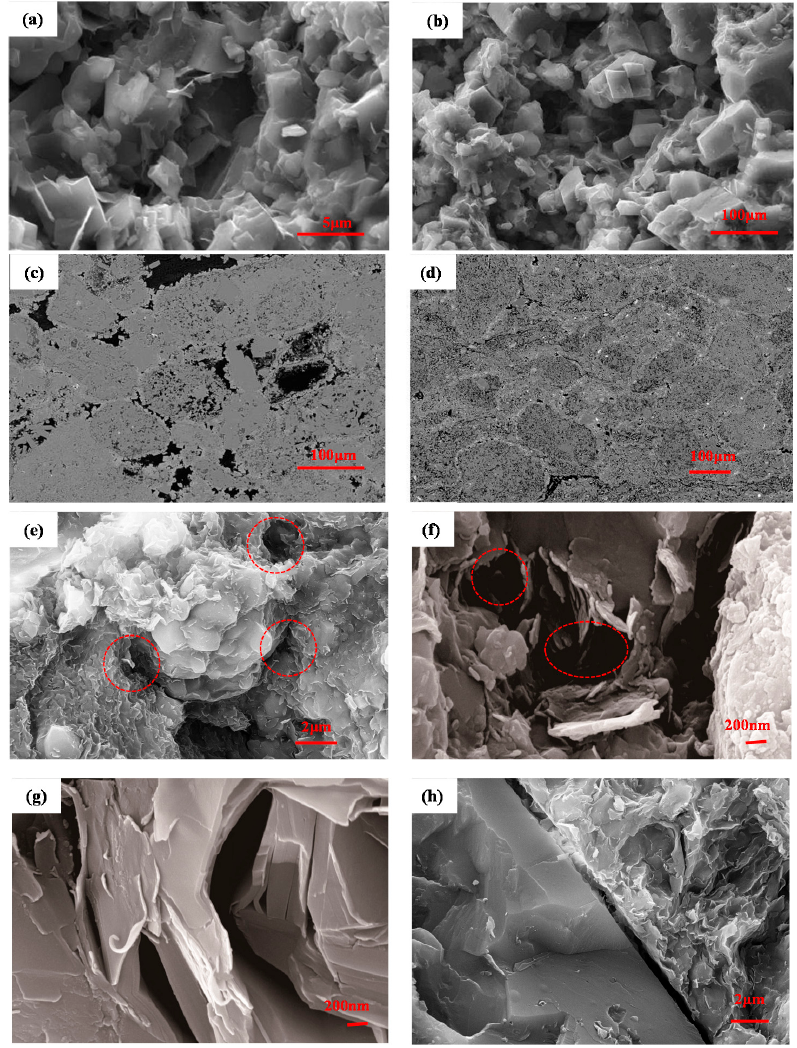
Figure 2. The pore types according to SEM analysis. ( a ) Intergranular dissolved pores; ( b ) Intergranular dissolved pores; ( c ) Intergranular and intragranular dissolved pores; ( d ) Intergranular and intragranular dissolved pores; ( e ) Illite/smectite mixed layer clay pores; ( f ) Chlorite clay pores; ( g ) Fracture pore; ( h ) Fracture